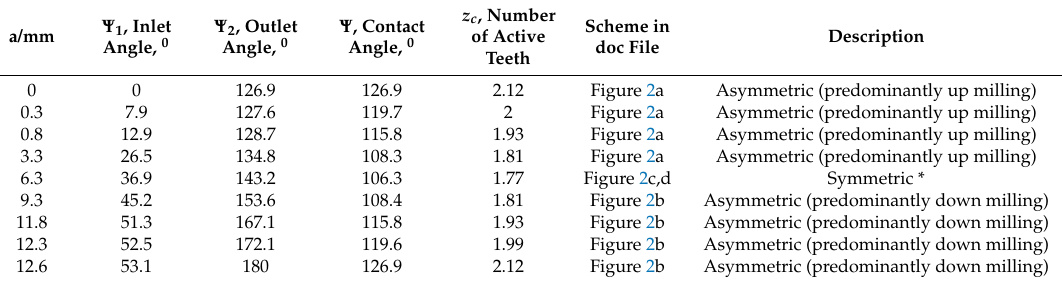
Figure 2. Types of installation of face Up and Down milling ( a i , uncut chip thickness; ψ 1 = ψ in , inlet angle; ψ 2 = ψ out , out angle; ψ , the contact angle; θ , tooth spacing angle; ψ i , angular coordinate of the i-th tooth; B , depth of milling; e , positions symmetry of cutter and workpiece; a (cid:48) , positions the end out of the cutter diameter and the beginning of the workpiece; D r , direction of rotary driven; D s , feed movement; 1, 2, 3, 1 (cid:48) , 2 (cid:48) , 3 (cid:48) , points determining the amount of chip scraps removed per one rotation of